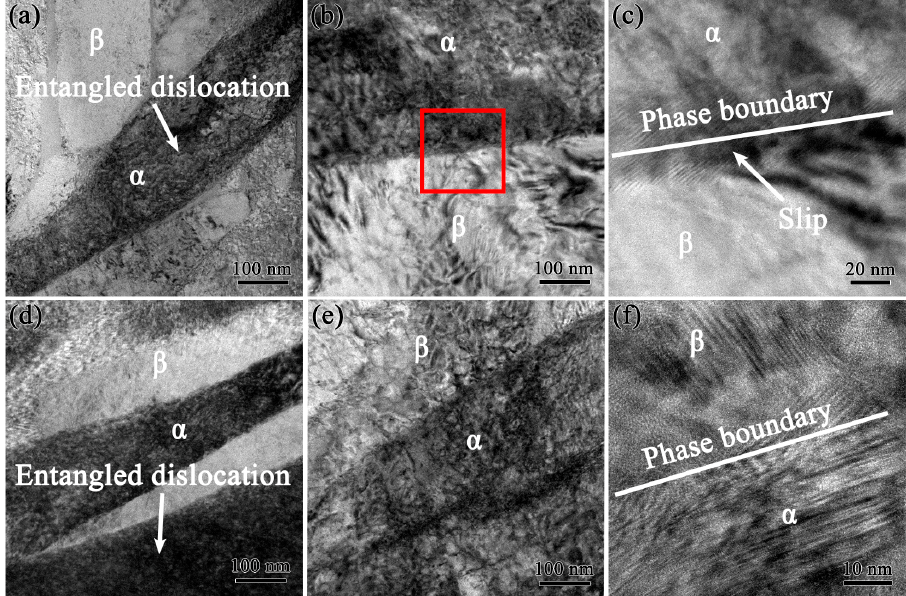
Figure 12. TEM images of the TC4 welded joint after the tensile fracture: ( a ) Uncharged sample after 10,000 cycles. ( b ) H-charged sample after 10,000 cycles. ( c ) Enlarged view of the area within the red wireframe in ( b ). ( d ) Uncharged sample after 30,000 cycles. ( e , f ) H-charged sample after 30,000 cycles.